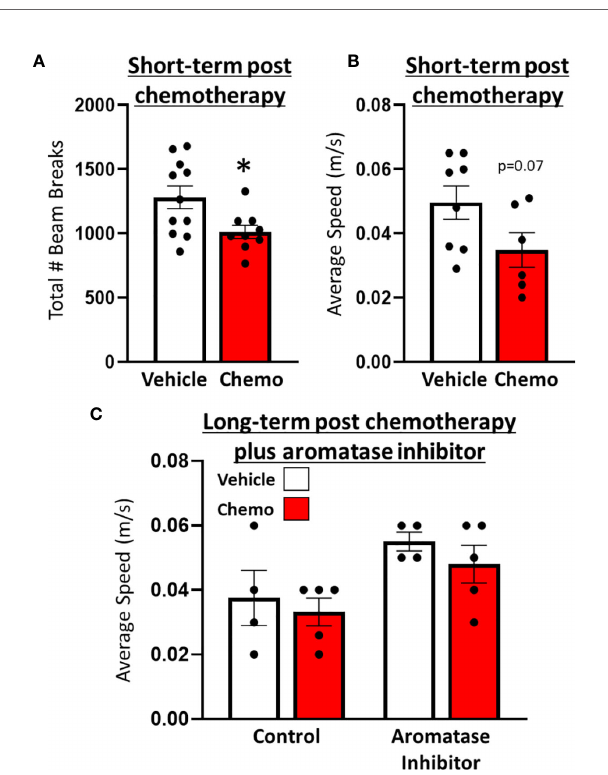
FIGURE 2 | Paclitaxel chemotherapy induced a transient decrease in locomotor activity following the fi nal dose in survivor mice. (A) Locomotion in an open fi eld test 1 day following the fi nal dose of paclitaxel (n=9) or vehicle (n=11). (B) Average speed (m/s) in a spontaneous alternations test following the fi nal dose of paclitaxel (n=6) or vehicle (n=8). (C) Average speed (m/s) in a spontaneous alternations test following aromatase inhibitor treatment (n=4/ group). Unpaired parametric two-tailed t tests were used for the short-term time point, and a one-way ANOVA was used for the long-term time point. Nonparametric Mann-Whitney U tests were used when the assumptions of normality and equal variances were not met. *p<0.05.